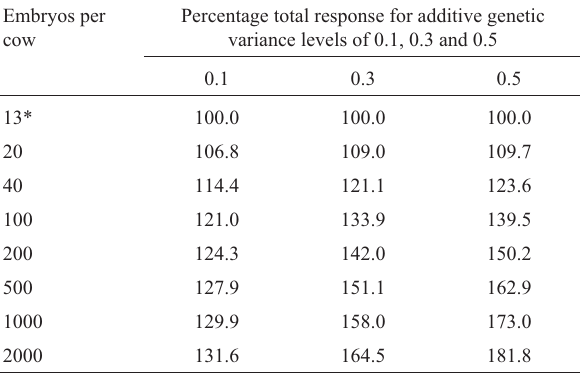
Table 7 - Scheme A4: Percentage total response for embryos per cow compared to the scheme in which 13 embryos were produced per cow (100%, first row) for the age at first calving quantitative trait locus (AFC-QTL) at additive genetic variance levels of 0.1, 0.3 and 0.5. Embryos per